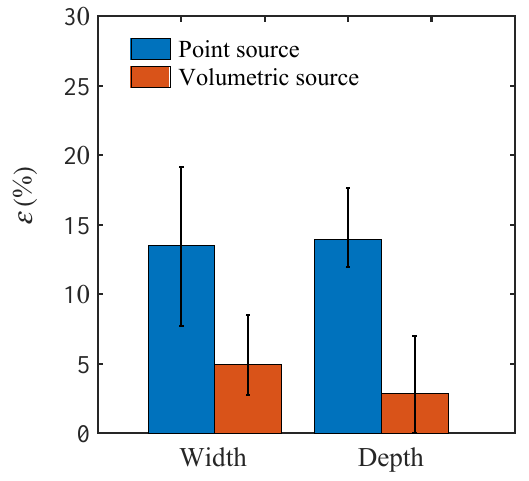
Figure 8. The errors ε = | Y − Y exp | / Y exp of the predicted width and depth with respect to the